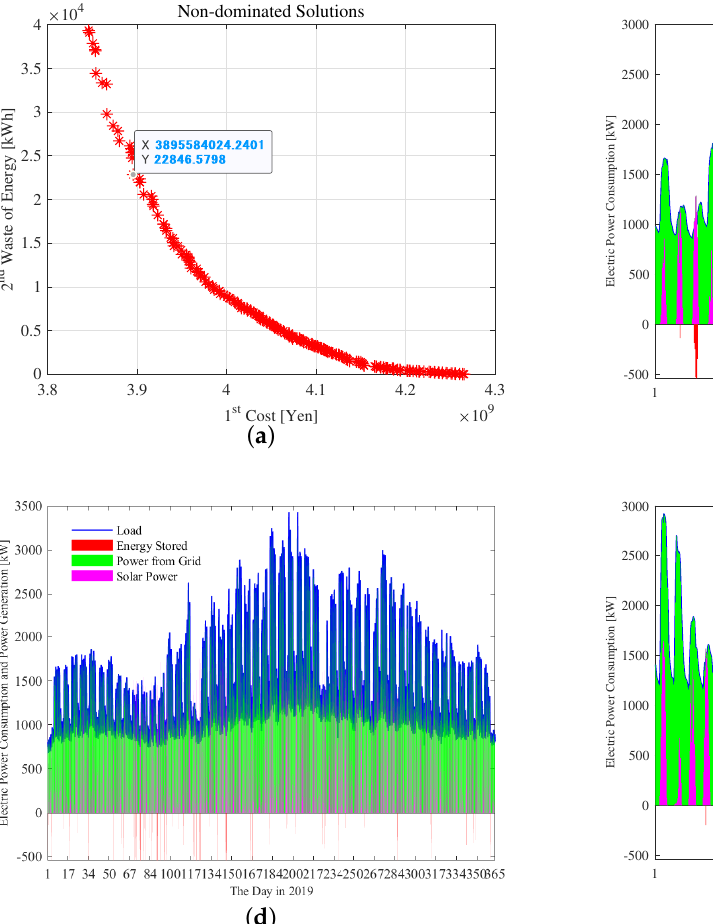
Figure 7. Pareto front and simulation results of Case 1. ( a ) Pareto front of Case 1; ( b ) Simulation result of February; ( c ) Simulation result of May; ( d ) Simulation result of the whole year; ( e ) Simulation result of August; ( f ) Simulation result of